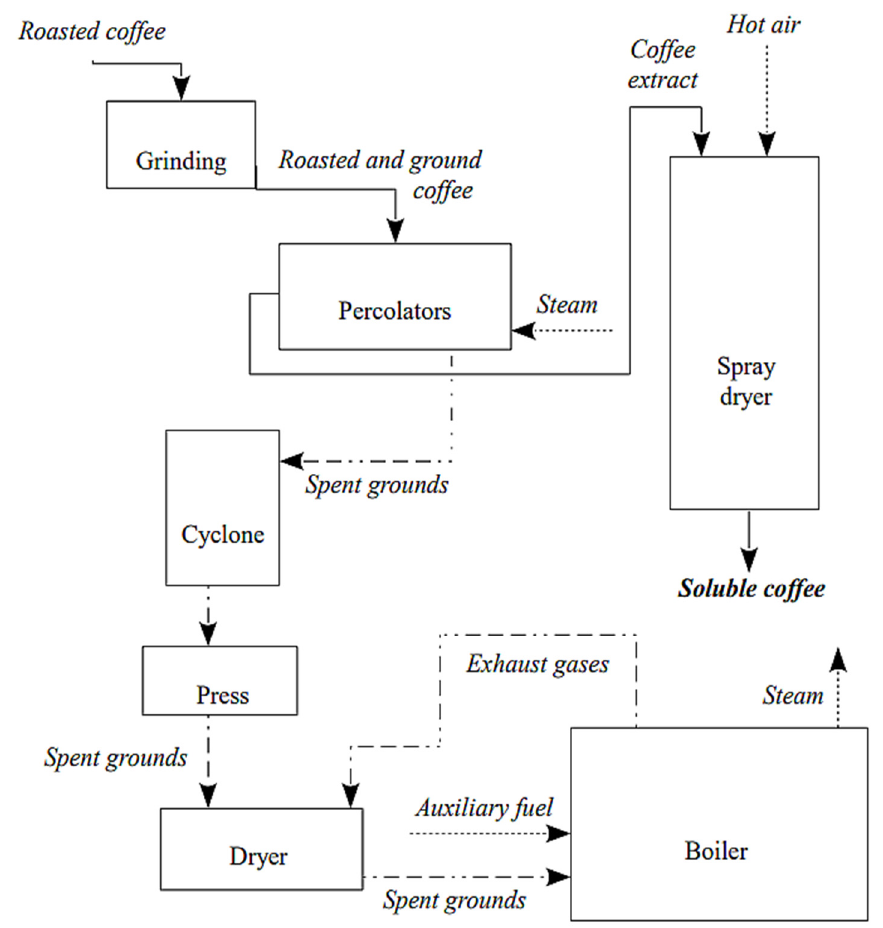
Figure 5. Scheme of the industrial production process of soluble coffee. Own compilation based on literature data [82].